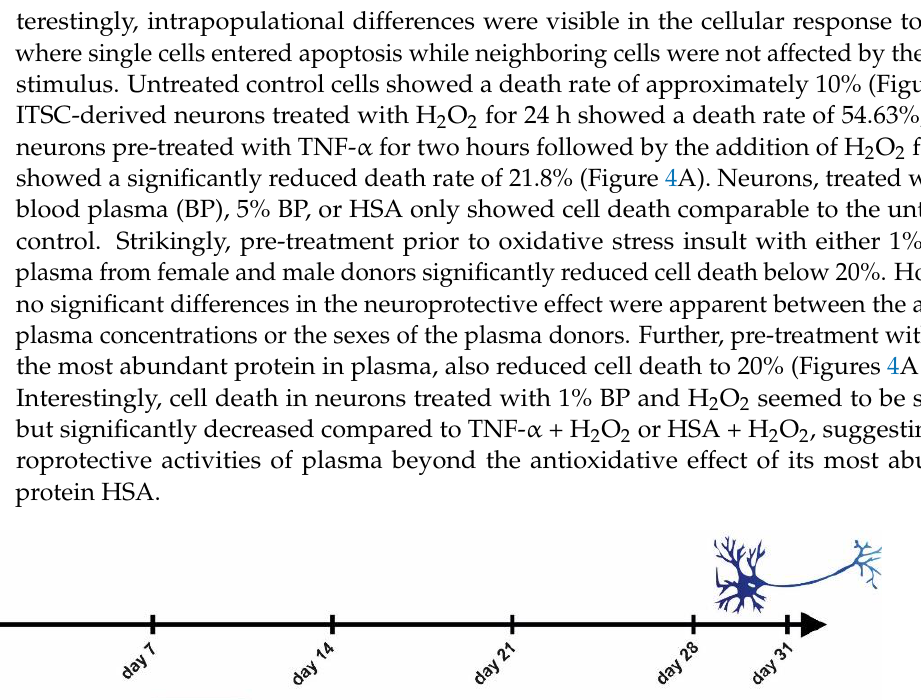
Figure 4. Human plasma mediates neuroprotection against oxidative stress ( A ) Nuclear counter- staining with 4′,6-diamidino-2-phenylindole (DAPI) (green color) showed the morphological changes in nuclear shape, indicated by strongly condensed or fragmented chromatin, after the dif- ferent treatments revealing an increase in cell death. Fragmented or condensed nuclei are indicated by a red arrow. ( B ) For analysis of human neuronal survival, the amount of nonviable inferior tur- binate stem cell (ITSC)-derived neurons recognized by nuclear condensation and/or fragmented chromatin was counted by randomized analysis of 5 pictures per treatment, and donor and death rate was calculated. Quantification of neuronal death for the data collected from three male plasma and two female plasma donors depicted no sex specificity, but an overall neuroprotective effect against oxidative stress treatment. ITSCs: inferior turbinate stem cells; TNF: tumor necrosis factor α; BP: blood plasma; HSA: human serum albumin, H 2 O 2 : hydrogen peroxide. * p ≤ 0.05, ** p ≤ 0.01, *** p ≤ 0.001 was considered significant.